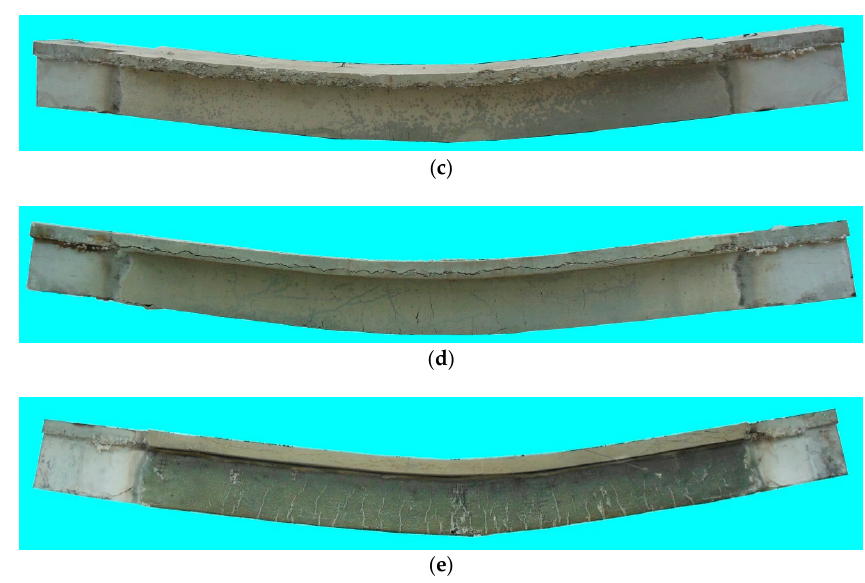
Figure 9. Photos of specimens after the fire tests: ( a ) Specimen B1, ( b ) Specimen B2, ( c ) Specimen B3, ( d ) Specimen B4, and ( e ) Specimen B5.